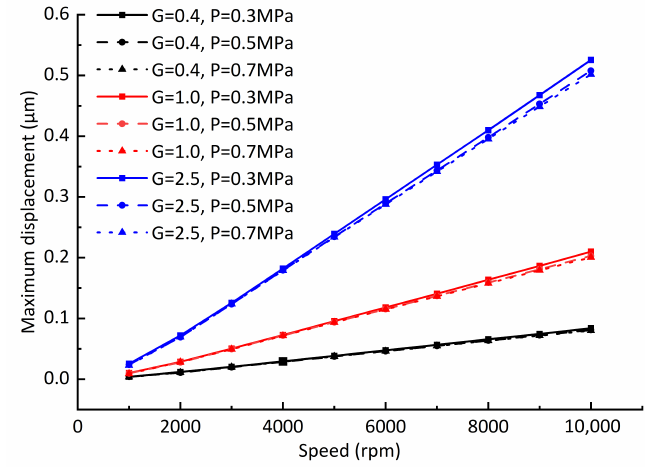
Figure 18. Influence of rotating speed on rotor dynamic equilibrium position offset (adding load F = 65